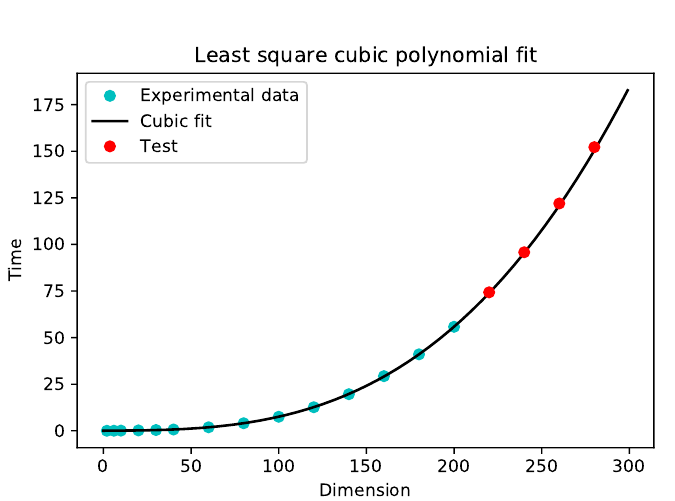
Figure 1. Least square cubic polynomial fit to the experimental data and test data for